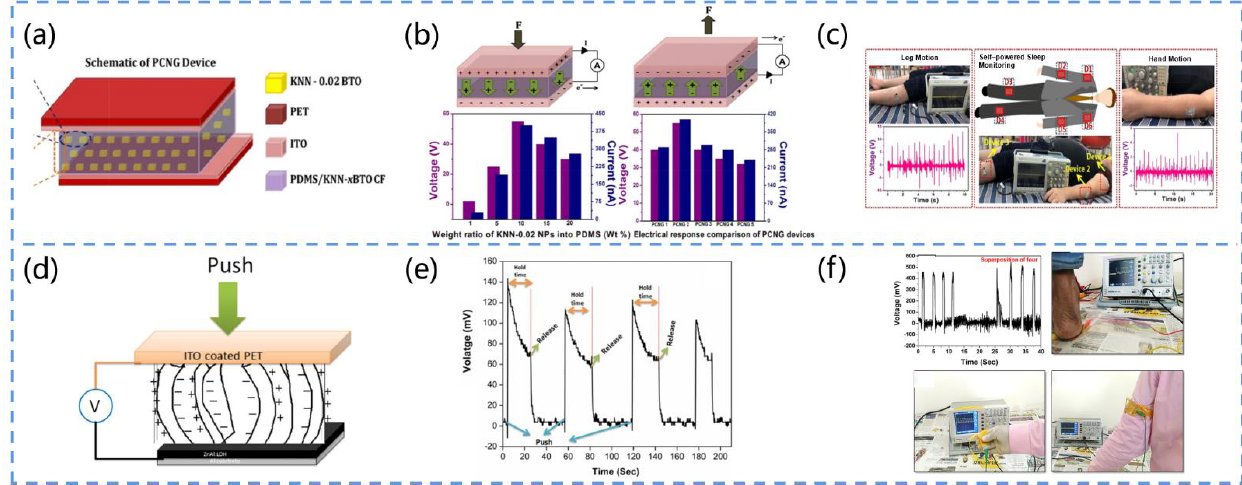
Figure 12. ( a ) Schematic diagram of the structure of the PCNG. ( b ) Schematic diagram of the device’s operating mechanism, output, and piezoelectric response ( I represents current, A represents ammeter, F represents force). ( c ) The device monitors leg and hand movements during sleep. Reprinted with permission from [142]. Copyright 2019, Elsevier. ( d ) Schematic diagram of the structure of the PENG ( V represents voltmeter). ( e ) Voltage pulses generated by the device under the action of an external force. ( f ) Photo of the piezoelectric output of four nanogenerators connected in series and the application of the device for muscle stretch testing. Reprinted with permission from [146].